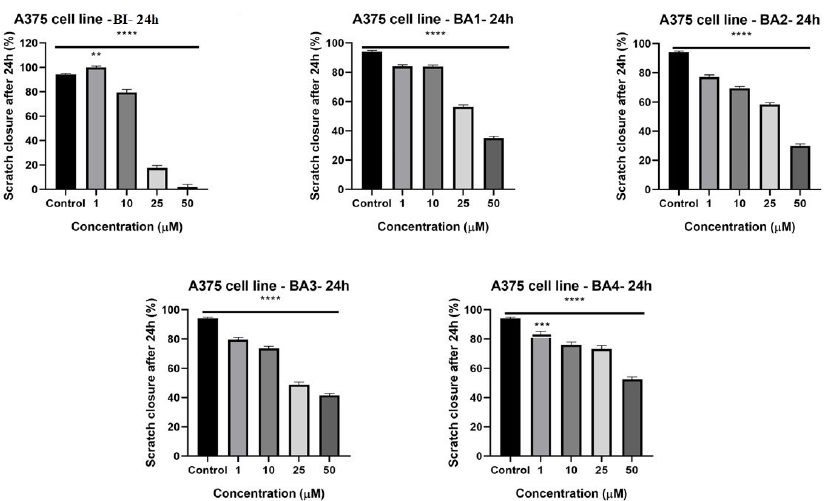
Figure 4. Images depicting the migratory potential of A375 cells after treatment with BI, BA1, BA2, BA3, and BA4 for 24 h. The bar graphs show the percentage of wound closure relative to the baseline surface after 24 h. The results are shown as the mean values ± SD of three separate trials carried out in triplicate. Applying the one-way ANOVA analysis and then Dunnett’s multiple comparisons post-test (** p ≤ 0.01; *** p ≤ 0.001; **** p ≤ 0.0001 vs. control) were used to determine the significant differences between the control and treated groups.